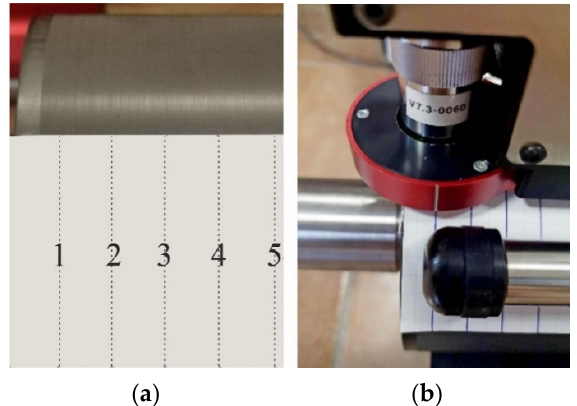
Figure 7. Measurement of the worn anilox roller: ( a ) a fixed scale along the axis of the roller; ( b ) alignment of the microscope with the position of the scale.